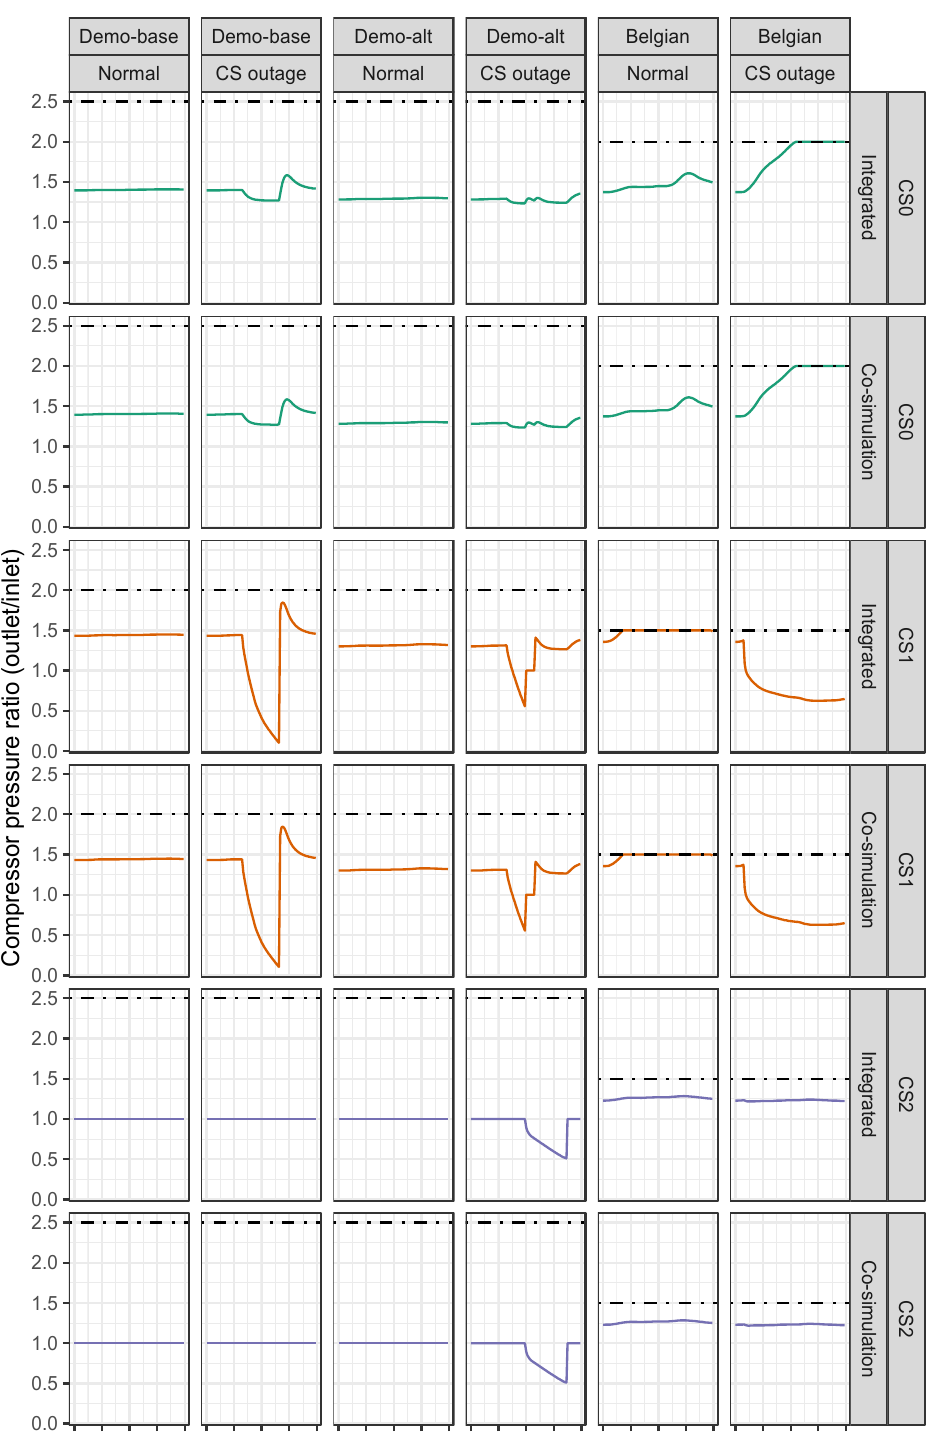
Figure 7. Comparison of pressure ratios (outlet/inlet) of each compressor station in the integrated and co-simulation approaches (rows) for each network and scenario tested (columns). Black dashed lines indicate the maximum allowable pressure ratio for each compression station. The maximum MAPE across all scenarios is 0.011%.